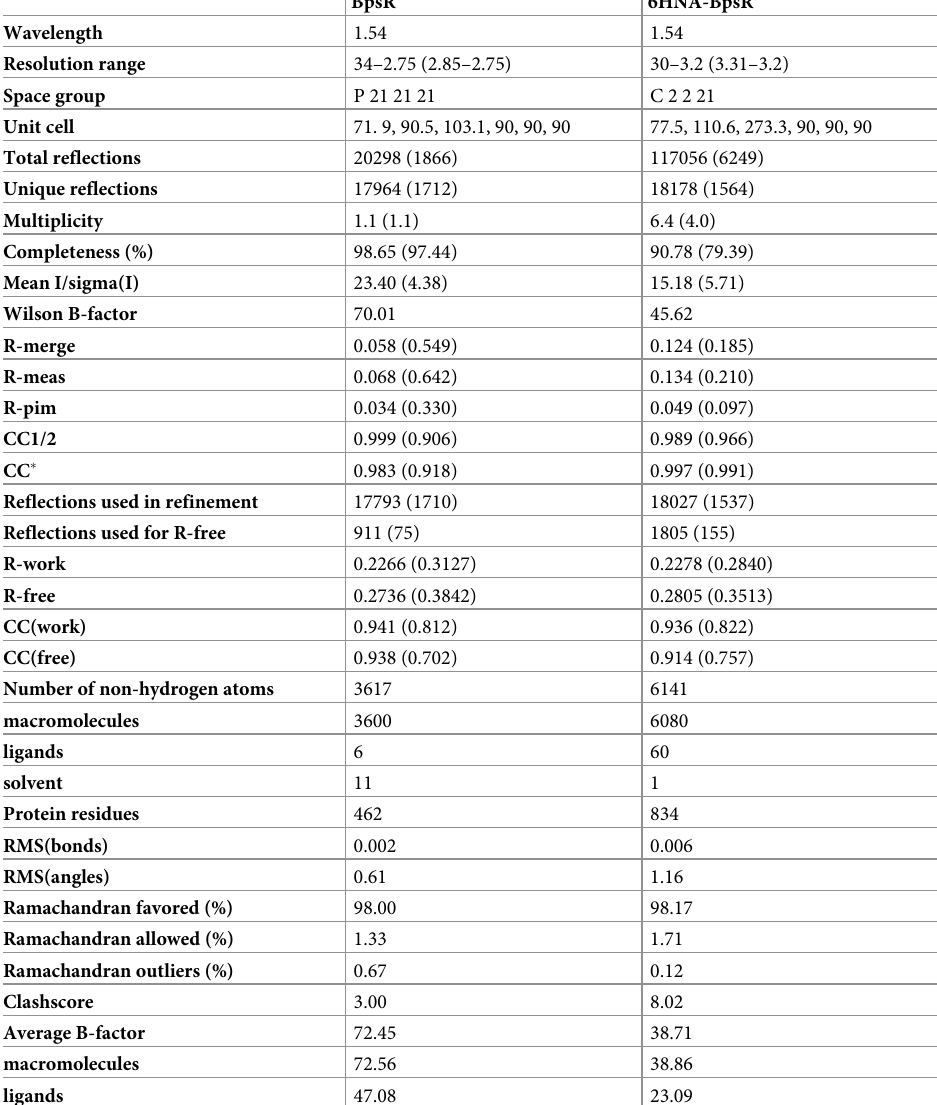
Table 1. Data collection and refinement statistics.